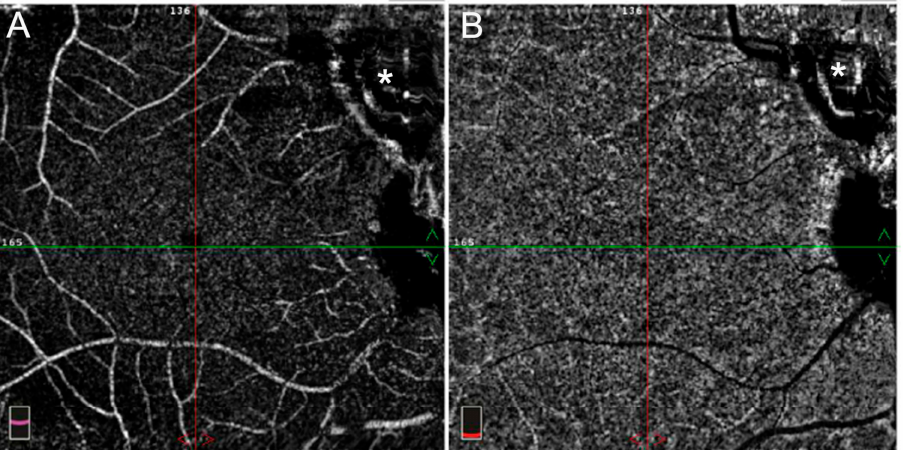
Figure 6. OCTA. Areas of flow void ( asterisk ) in superficial ( a ) and deep ( b ) vascular plexus, corresponding to granulomas with vessels starting to grow irregularly at the edge of the lesions during the healing process.